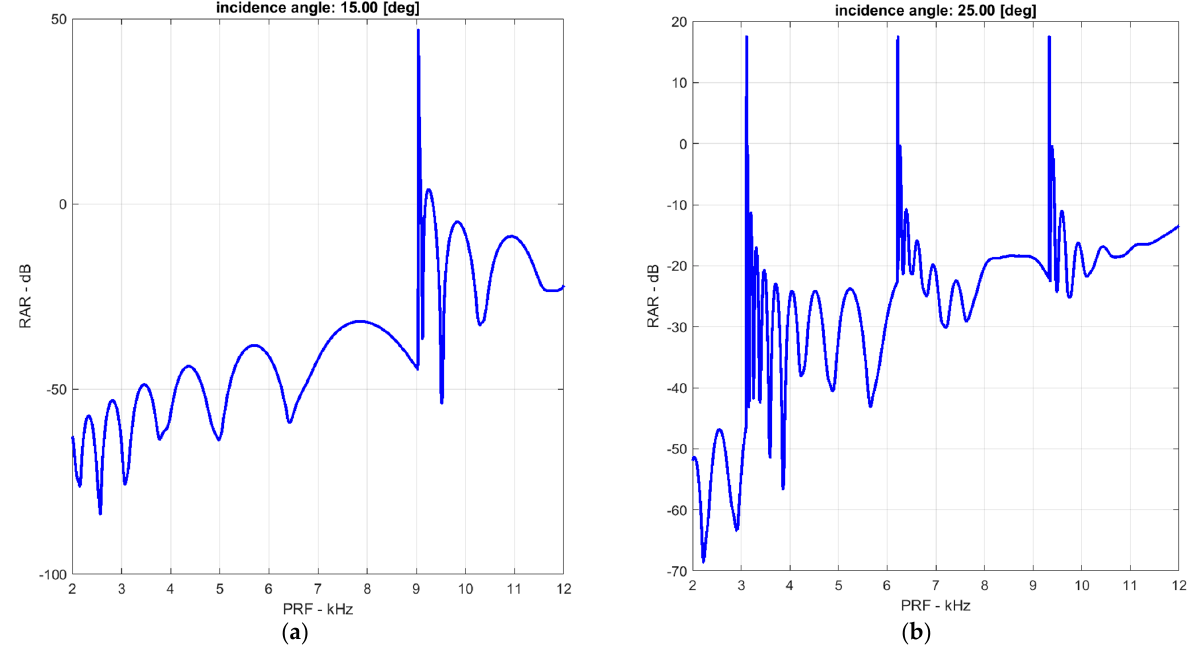
Figure 28. Range ambiguity ratio vs. PRF at an incidence angle of ( a ) 15 and ( b ) 25°.